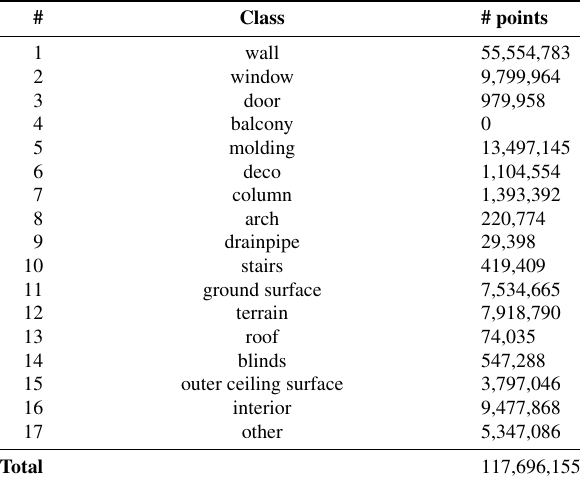
Table 3. Annotated classes and points distribution in the TUM-FAC¸ADE